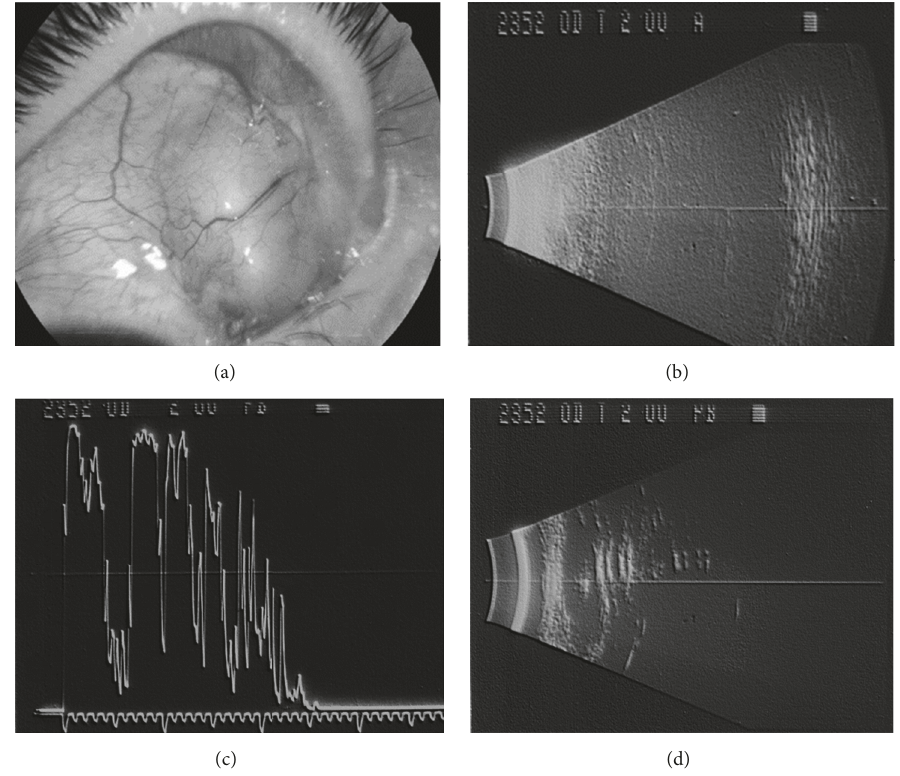
Figure 1: (a) Picture of the dome shaped lesion in the upper nasal quadrant. (b) B scan echographic image showing a classical lengthened image with a flattening and weakening of the posterior eye wall, for the presence of silicon oil in the vitreous chamber. (c) A scan echographic image showing a medium-low reflective lesion followed by a chain of multiple signals. (d) B scan echographic image showing a classical lengthened and weakened image due to the presence of silicon oil in the upper medial episcleral